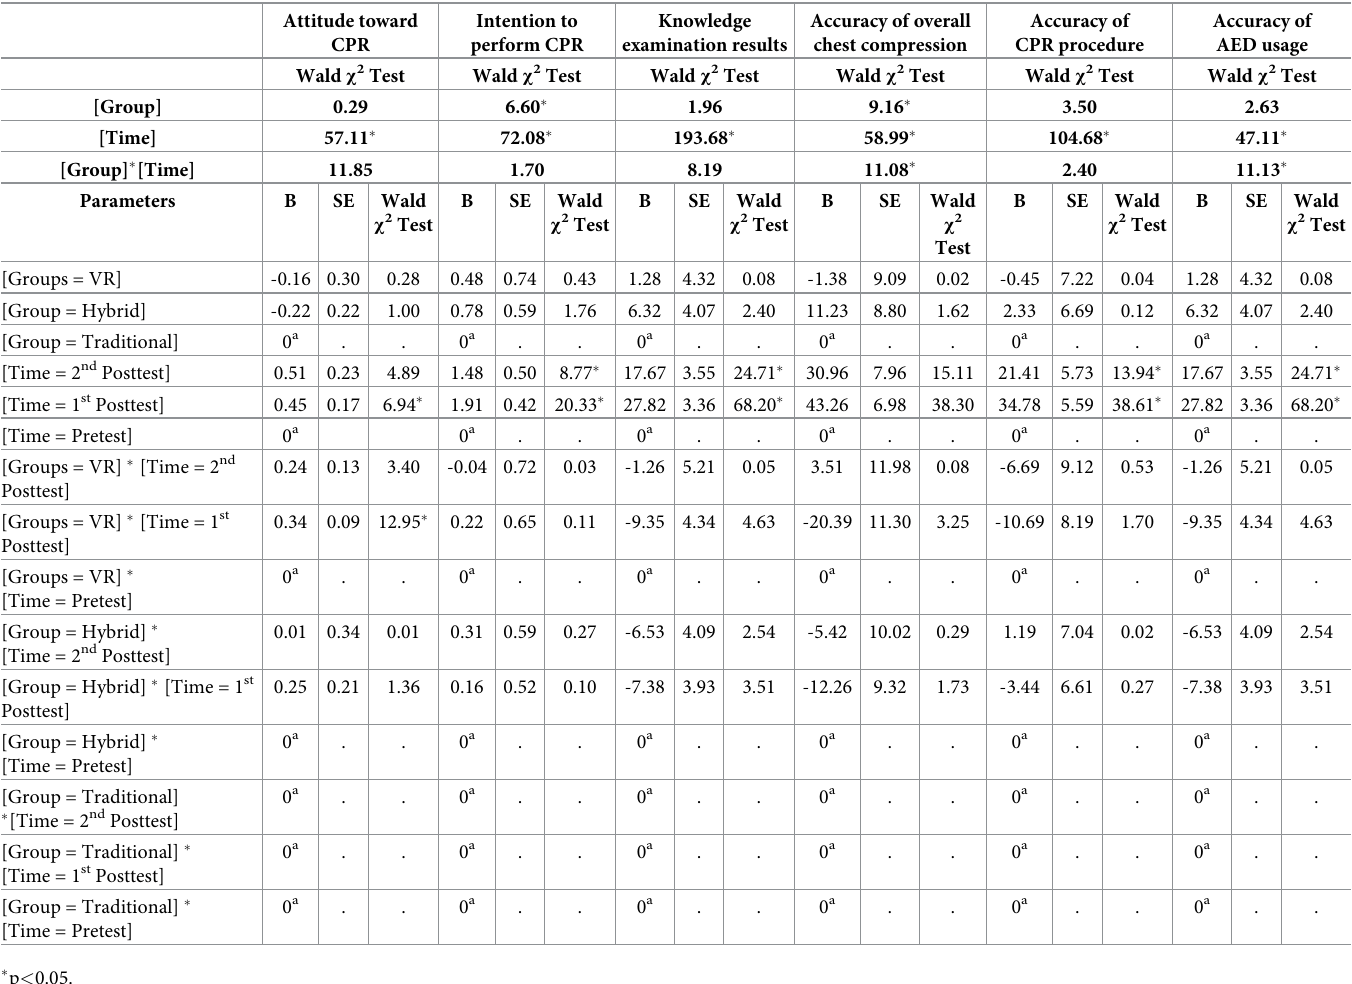
Table 3. Analysis of the interaction between CPR education intervention groups and time to CPR learning